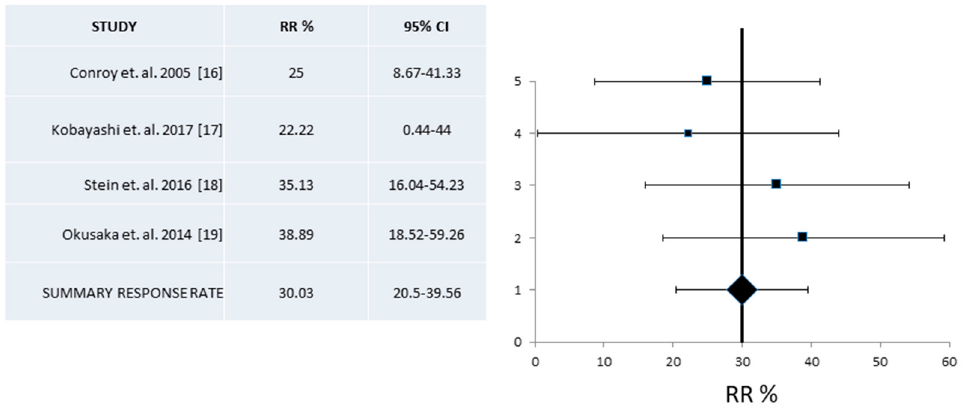
Figure 6. Pooled analysis of Response Rates (RR) and 95% Confidence Intervals (CI) from phase II trials. Four trials with a total of 127 patients that provided information for the RR were included and showed an overall RR of 30% (95% CI 20.5–39.6%).